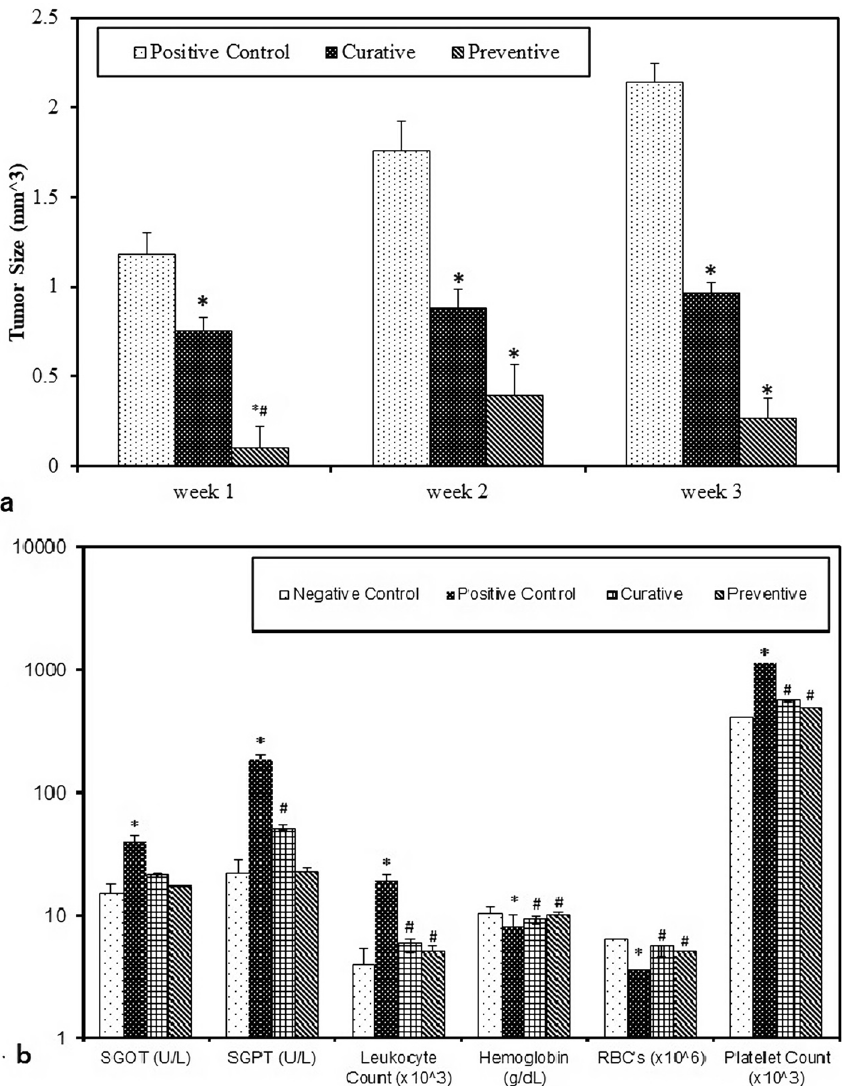
Figure 6. In vivo biological effects of O. dentata in Ehrlich tumor-bearing mice including ( a ) tumor size measurements ( b ) hematological parameters and liver function tests in study